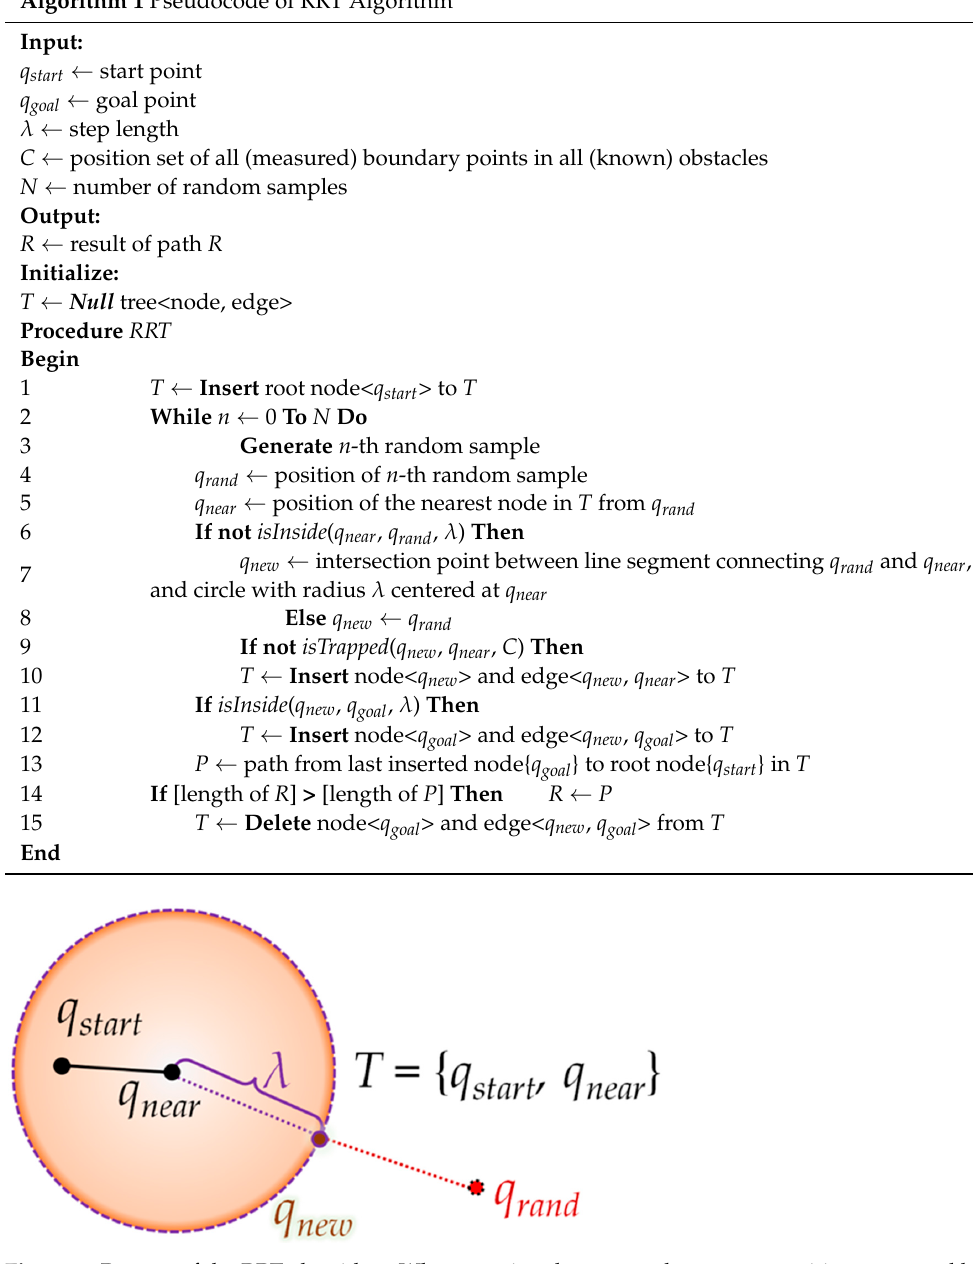
Figure 2. Process of the RRT algorithm: When creating the new node q new at a position separated by step length λ in direction of random sample position ( q rand ) based on q near node (position) closest to random sample position ( q rand ) in tree T with starting point q start as the root node.